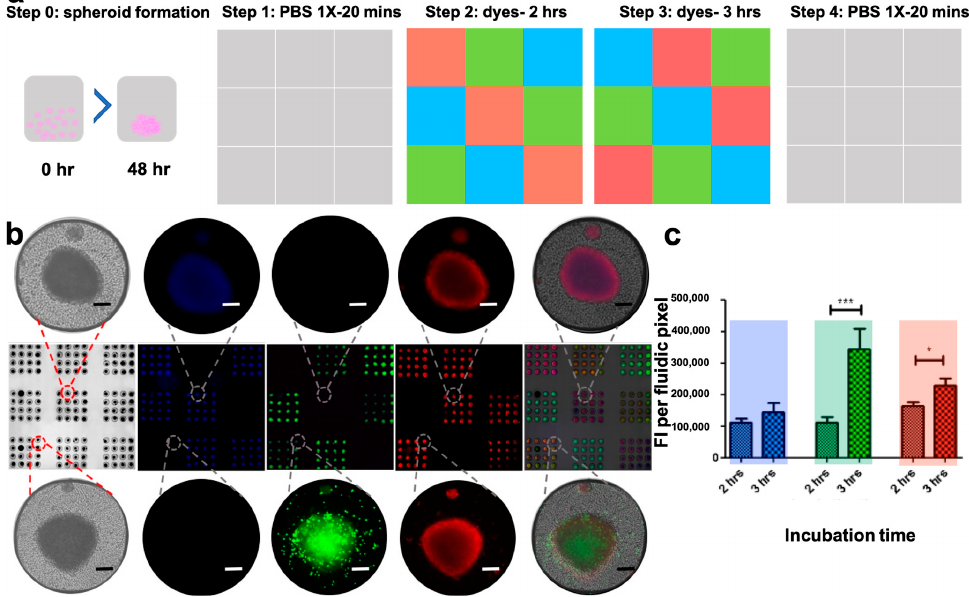
Figure 4. Crosstalk ‐ free multiplexed staining of tumour models using the PCD. The PCD is used to stain HCT ‐ 116 spheroids 48 h after cell seeding. Spheroids were first subjected to three different cellular dyes streaming at the nine pixels of the PCD for two hours. Then, the reagents were switched to stream a different dye at each pixel for 3 h. Spheroids were imaged using an inverted fluorescent microscope after rinsing out the dyes. Staining protocol ( a ), micrographs of stained sphe ‐ roids taken at the end of the experiment ( b ), and quantification of Fluorescence Intensity (FI) of spheroids for each channel ( c ). Longer incubation with fluorophores results in a higher fluorescent emission from the spheroids. Blue: Hoechst and DAPI, green: Celltracker™ Green, red: Celltracker™ Red. Scale bars = 100 μ m. ( b , c ) represent one assay. 3 Spheroids in each pixel (9 sphe ‐ roids per channel) were used to produce the plot in ( c ). Error bars = SEM. * p < 0.05; *** p < 0.0001.